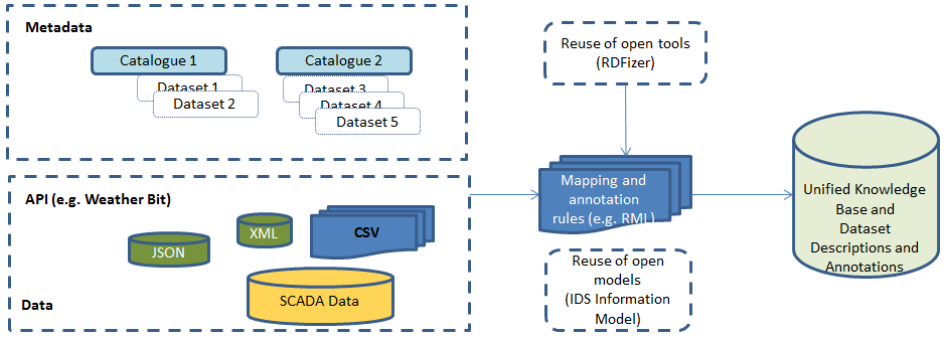
Figure 7. Data harmonization pipeline.